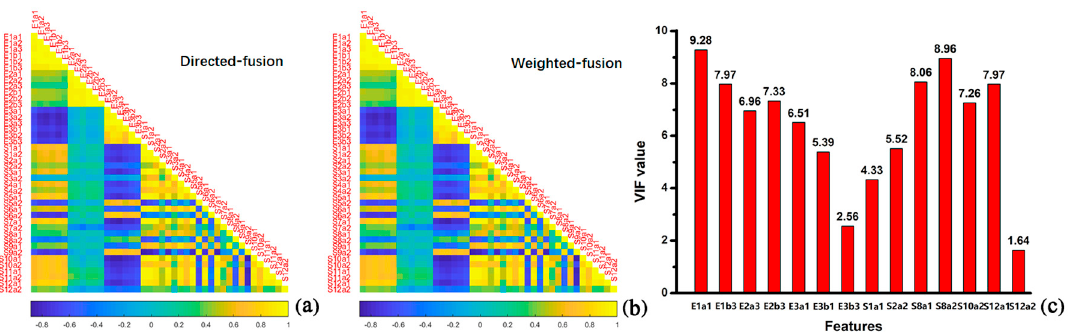
Figure 8. Visualization of the correlations between sensor signals based on Pearson correlation matrix: ( a ) Direct-fusion data set; ( b ) weighted-fusion data set. Plot of variance inflation factor (VIF) values calculated for the optimized characteristic data sets after direct-fusion and weighted-fusion ( c ).